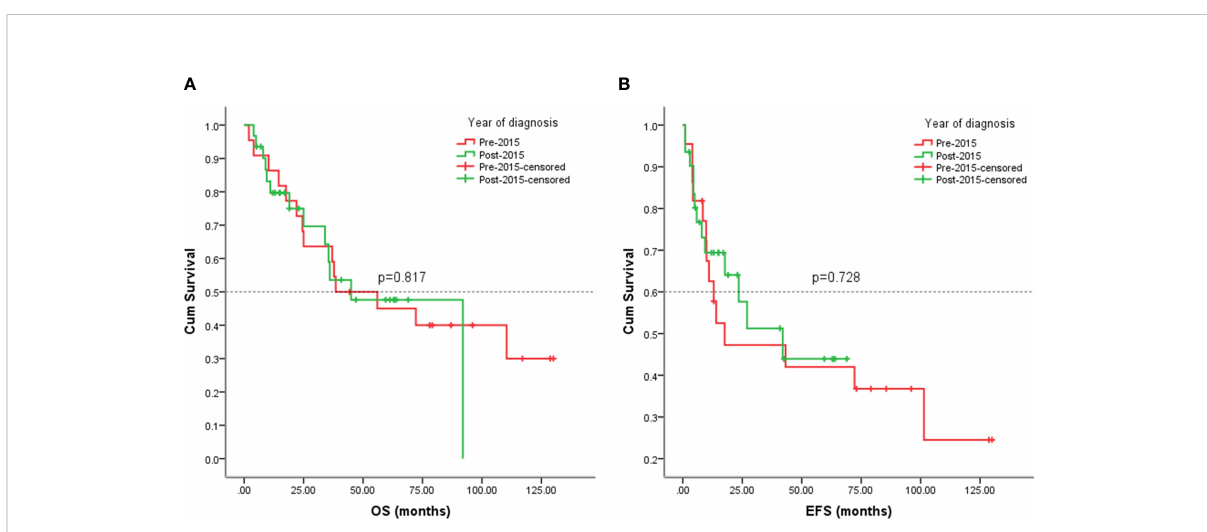
FIGURE 9 Kaplan-Meier analysis of OS and EFS for patients diagnosed with visceral sarcomas pre-2015 and post-2015. (A) Kaplan-Meier analysis of OS for patients diagnosed with visceral sarcomas pre-2015 and post-2015 (p=0.817). (B) Kaplan-Meier analysis of EFS for patients diagnosed with visceral sarcomas pre-2015 and post-2015